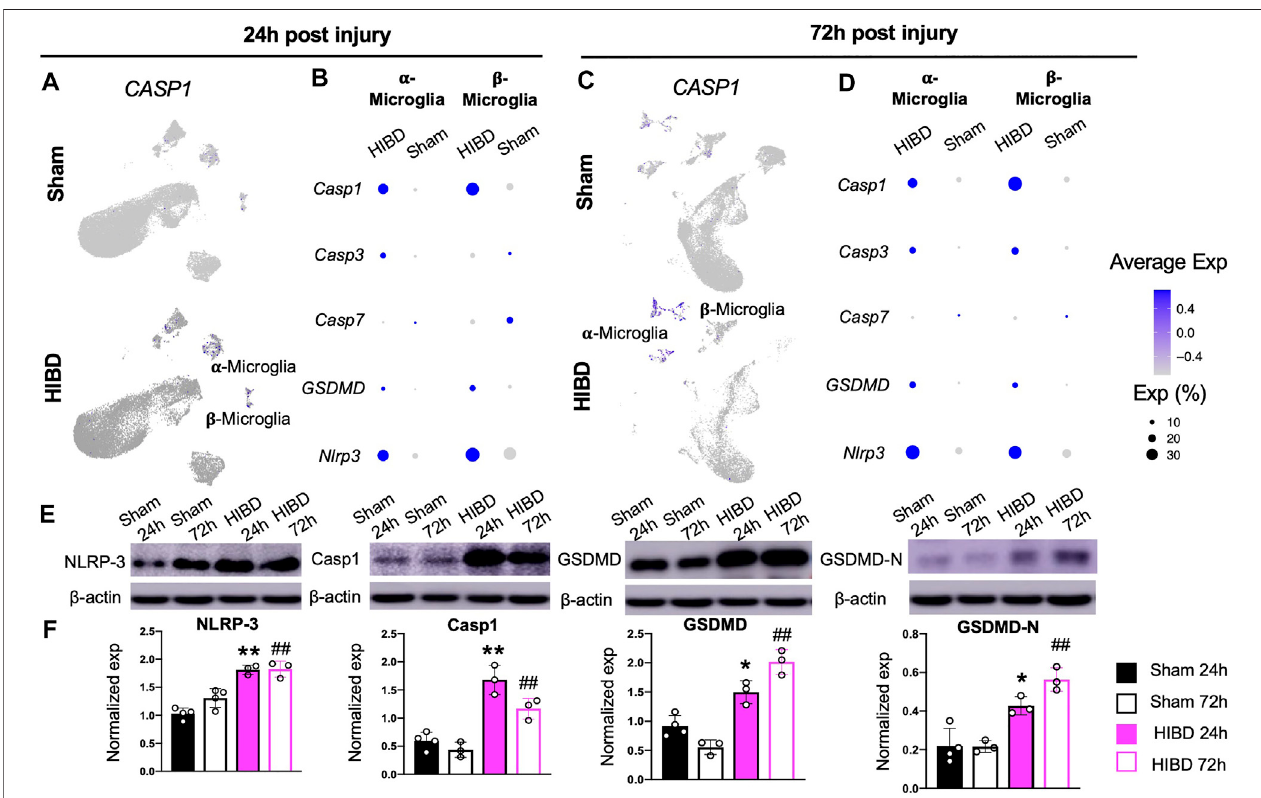
FIGURE7| MicroglialpyroptosispostneonatalHIBD (A,C) Featureplotsofapyroptosisspeci fi cfactor( Caspase-1 )overtotalpinealpopulationsat24 h (A) or72 h (C) postshamorneonatalHIBD,respectively (B,D) Bubble plotsshowingexpression levelsofpyroptosisand apoptosisrelated genesat24 h (B) or72 h (D) postsham or neonatal HIBD, respectively (E – F) Western blotting (E) with quanti fi cation (F) of NLRP-3, Capase-1, GSDMD, and GSDMD-N. in F, for each lane, the expression of a given protein is fi rst normalized to that of β -actin. ** or *, p < 0.01 or 0.05 (sham and HIBD 24 h), ## (sham and HIBD 72 h), p < 0.01, n = 3 for each condition, one- way-ANOVA with Bonferroni ’ s multiple-comparisons post hoc